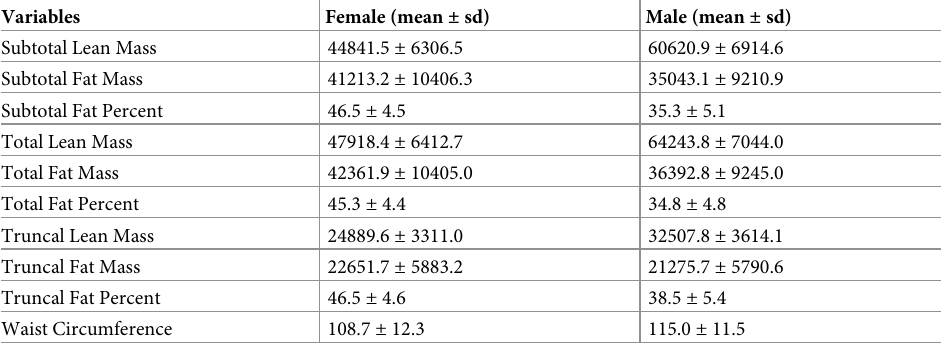
Table 2. Body composition metrics for females and males from the LOOK AHEAD study cohort.